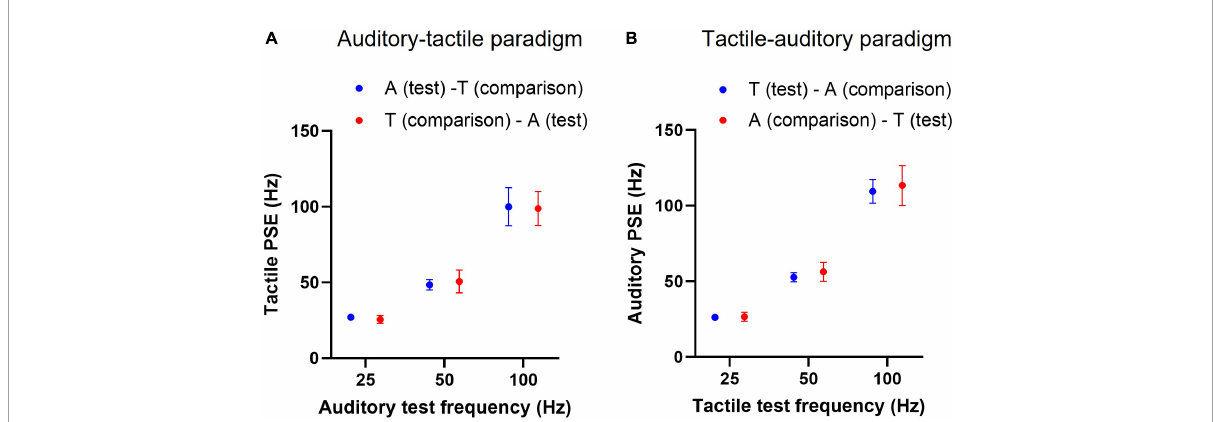
FIGURE5 Cross-modal point of subjective equality (PSE) with test stimulus presentation order. (A) Mean tactile PSEs ( n = 12) of an auditory test train when it precedes or follows the tactile comparisons in psychophysical frequency discrimination trials. “A (test)–T (comparison)” indicates an auditory test stimulus preceding the tactile comparison stimuli, and “T (comparison)–A (test)” denotes the opposite presentation order. (B) Similarly, mean auditory PSEs for a tactile test train at two conditions, conventions as in panel (A) . Error bars indicate ± 95% CI.